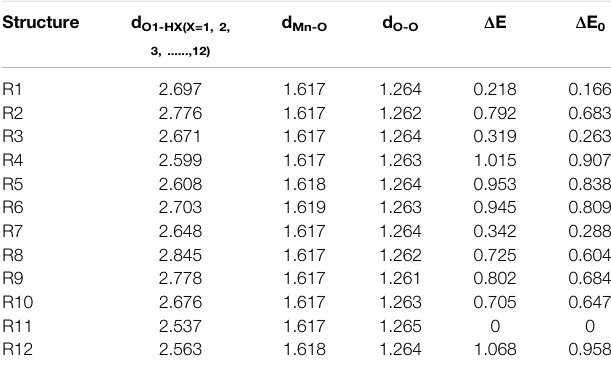
TABLE 1 | | O1-HX (X = 1, 2, 3, ..., 12), Mn-O, O-O bond lengths (Å), relative electronic energies and zero-point energies ( Δ E, Δ E 0 , kcal/mol). Structure